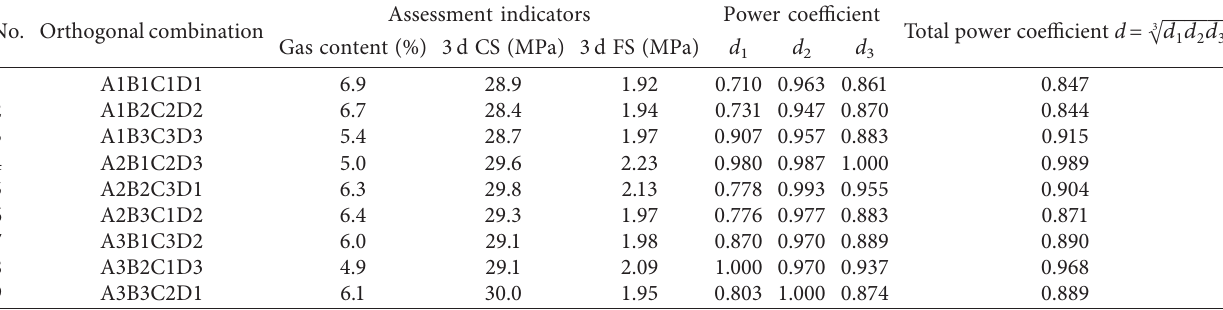
Table 7: The results of orthogonal experiments.